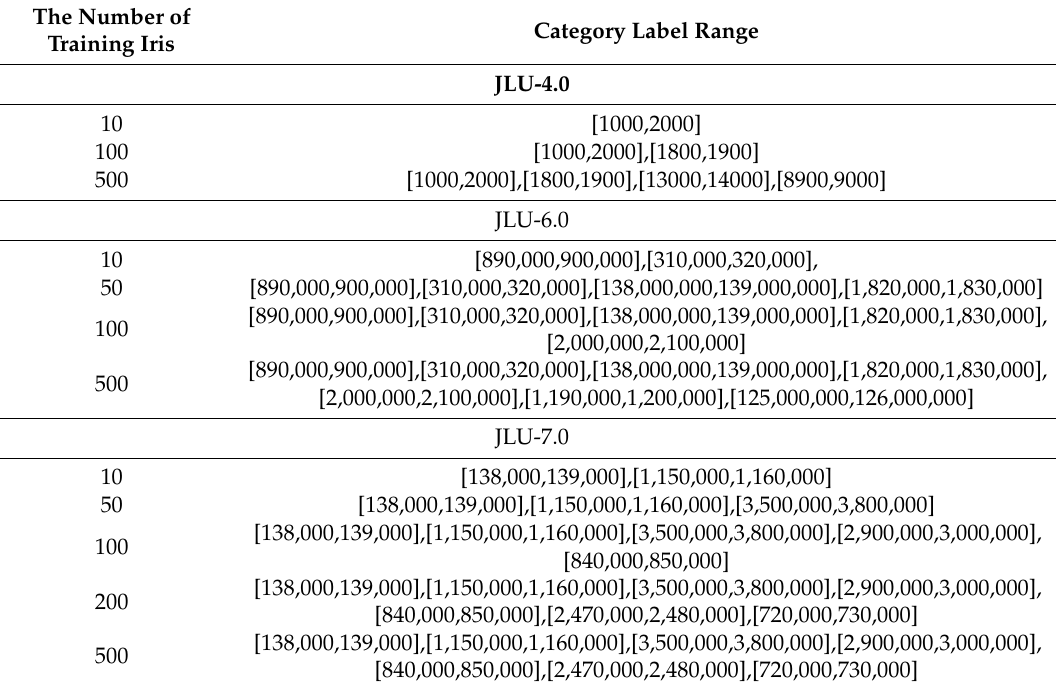
Table 15. The change situation of category label range